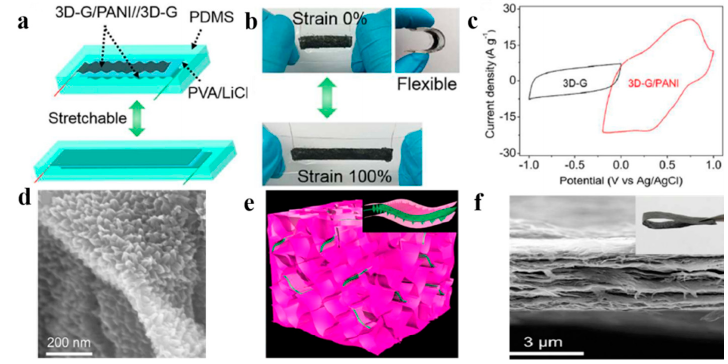
Figure 15. ( a ) Stretchable supercapacitors consisting of 3D graphene/polyaniline (3D-G/PANI) and 3D-G; ( b ) Good stretchability of the supercapacitor; ( c ) The 3D-G/PAN film shows an excellent capacitance performance; ( d ) Morphology of GO/PANI composite nanosheets with the grown PANI; ( e ) A 3D schematic of the GO/PANI nanomaterial embedded in the graphene skeleton (the top right corner is a partial enlargement); ( f ) A side-by-side screenshot of the composite film. Reproduced from [93], with permission from Royal Society of Chemistry,